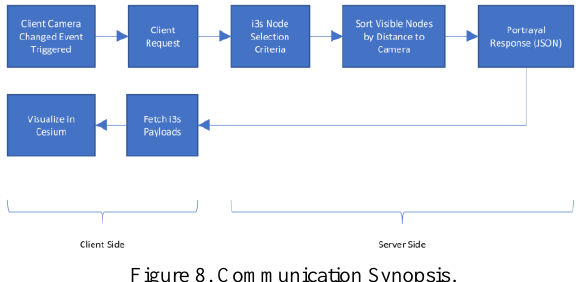
Figure 8. Communication Synopsis.